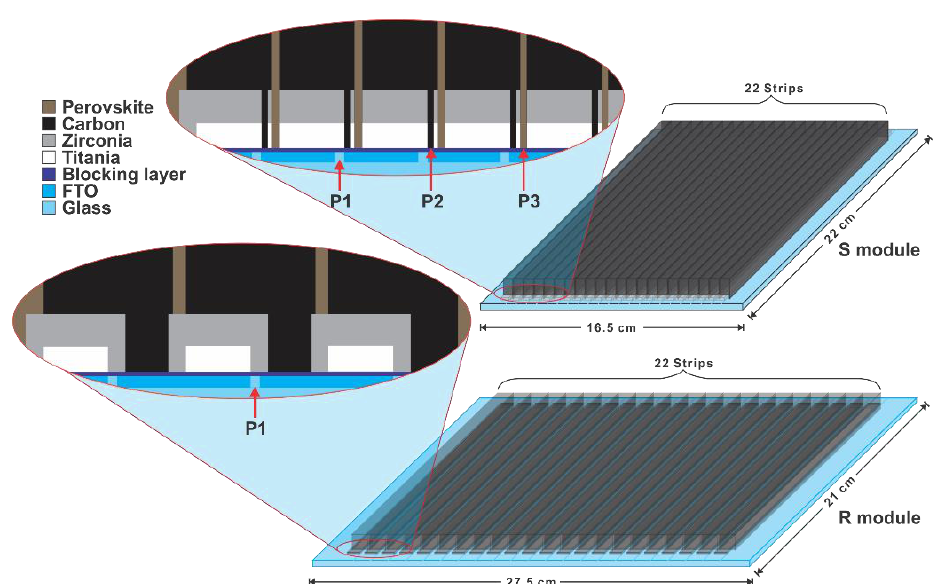
Figure 2. Schematic representation of C-PSC modules fabricated using registration (R) and scribing (S) methods.